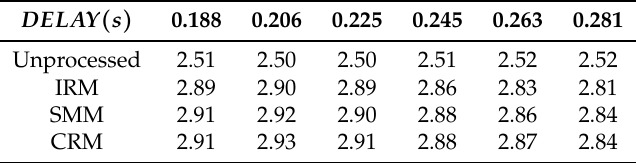
Table 4. Effect of time delay on PESQ.